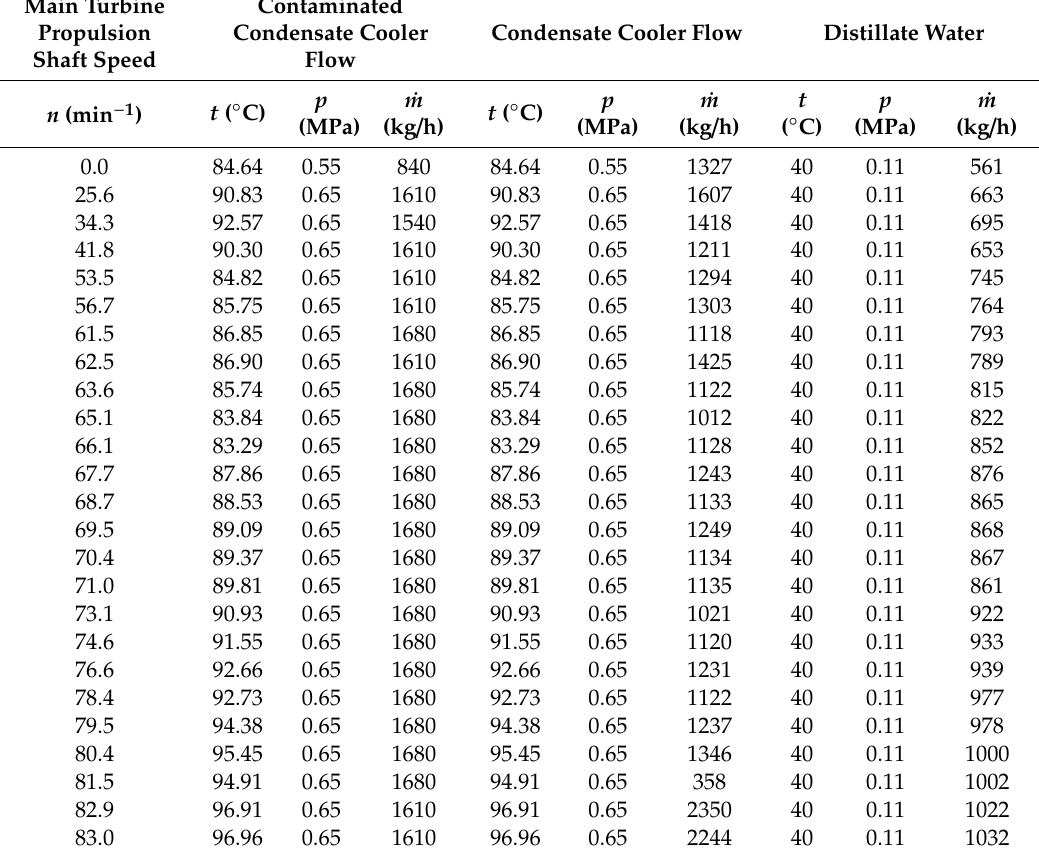
Table A4. Optimized temperature from contaminated condensate cooler outlet, clean condensate cooler outlet and distillate tank outlet to atmospheric drain